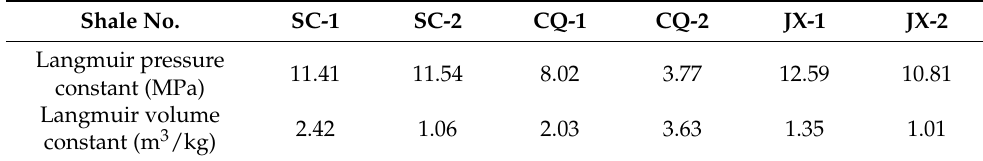
Figure 10. The relationships between multifractal characteristic parameters of organic pores and Langmuir parameters.